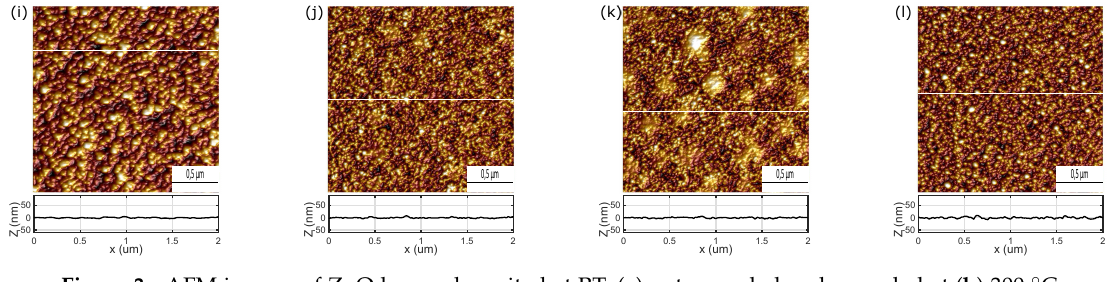
Figure 3. AFM images of ZnO layers deposited at RT: ( a ) not annealed and annealed at ( b ) 300 ◦ C, ( c ) 500 ◦ C and ( d ) 800 ◦ C and deposited at 100 ◦ C: ( e ) not annealed and annealed at ( f ) 300 ◦ C, ( g ) 500 ◦ C and ( h ) 800 ◦ C as well as deposited at 200 ◦ C: ( i ) not annealed and annealed at ( j ) 300 ◦ C, ( k ) 500 ◦ C and ( l ) 800 ◦ C.